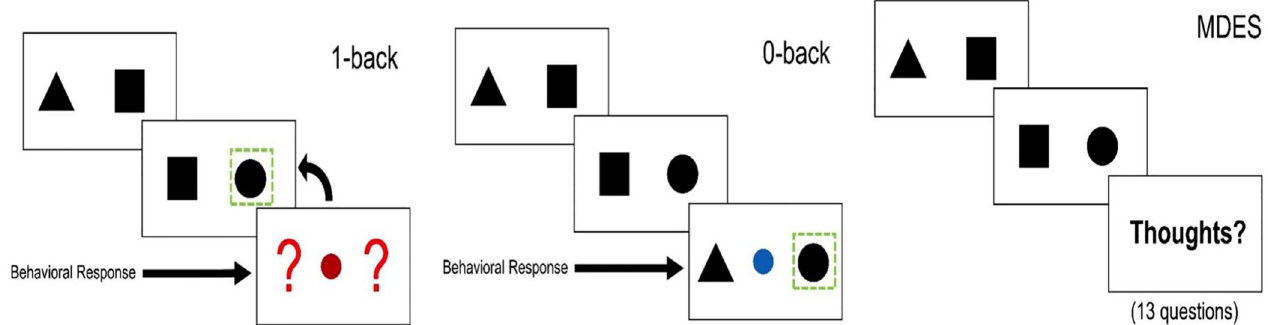
Fig 1. Multidimensional Experience Sampling (MDES). An n-back task was used to measure on-going thought in the laboratory, which alternated between an easy 0-back task and a more demanding 1-back task. In non-target trials, a pair of shapes appeared on screen. Following an unpredictable sequence of non- target trials, a target trial was presented in which participants had to make a manual response. Left-hand panel: in the 1-back condition, the target was flanked by two question marks, and participants had to respond depending on which side the target shape had been on during the prior trial. Middle panel: in the 0-back condition, the target was flanked by one of two shapes, and participants had to indicate which shape matched the target shape by pressing the appropriate button. Right-hand panel: at the moment of target presentation there was a 20% chance of a MDES thought probe being presented instead of a target. Participants answered 13 questions (see Table 1) on a 4-point scale ranging from 0–1. The first thought probe asked participants to rate their level of task focus (“My thoughts were focused on the task I was performing”) on a sliding scale from 0 (completely off-task) to 1 (completely on task). Participants then answered 12 randomly presented questions regarding the content and form of their experience in the moments just before they answered the first thought probe (on level of task focus).